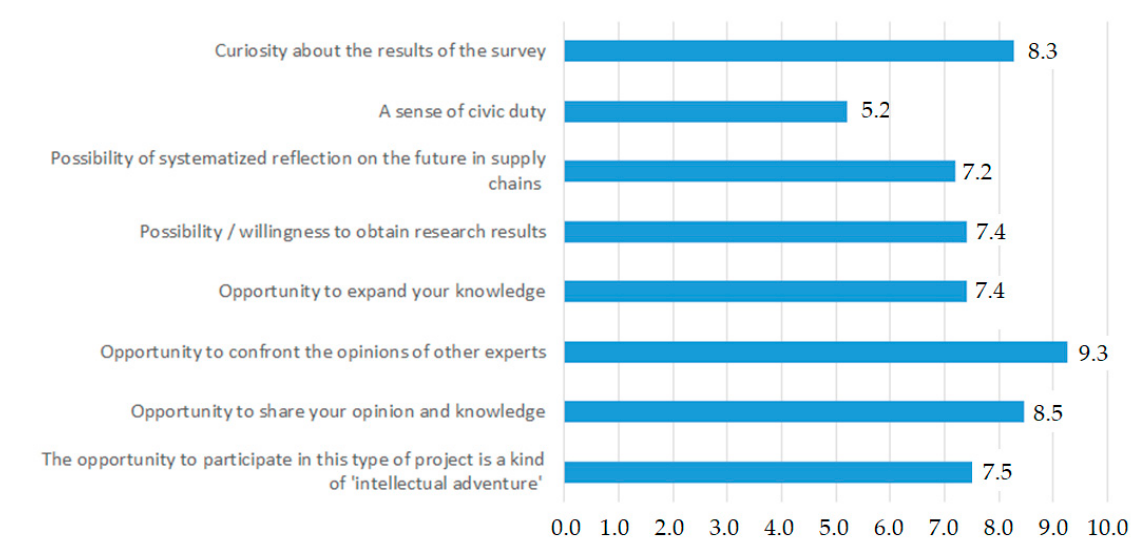
Figure 6. The motivation of experts to take part in the Delphi method study (mean values, sample n = 30); own elaboration based on the conducted research.